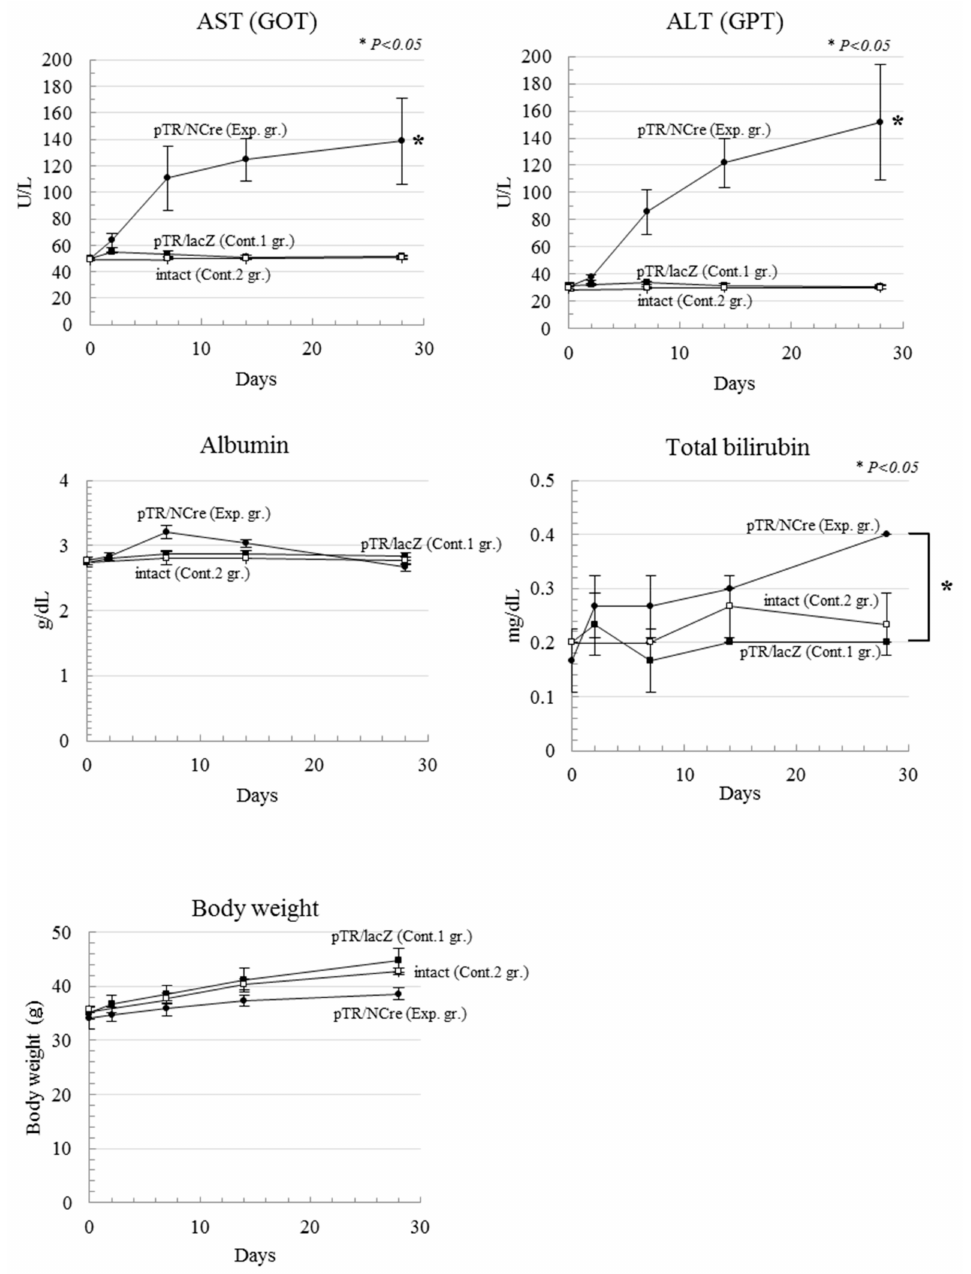
Figure 3. Hydrodynamics-based gene delivery and PB transposon system enable the creation of disease models for liver dysfunction: abnormal serum biochemical parameters and reduced body weight in the pT-CETD-incorporating males assayed 2, 7, 14, and 28 days after the second HGD with pTR/NCre (experimental group (Exp.gr.)) or pTR/lacZ (control-1 group (Cont.1 gr.)). Intact ICR males (in control-2 group (Cont. 2 gr.); with mice of the same age as in the experimental group) were also analyzed on 0, 7, 14, and 28 days. The level of significance set at p < 0.05 marked with an asterisk. Values are expressed as mean ± standard deviation among three mice tested for each group. AST, aspartate aminotransferase; ALT, alanine